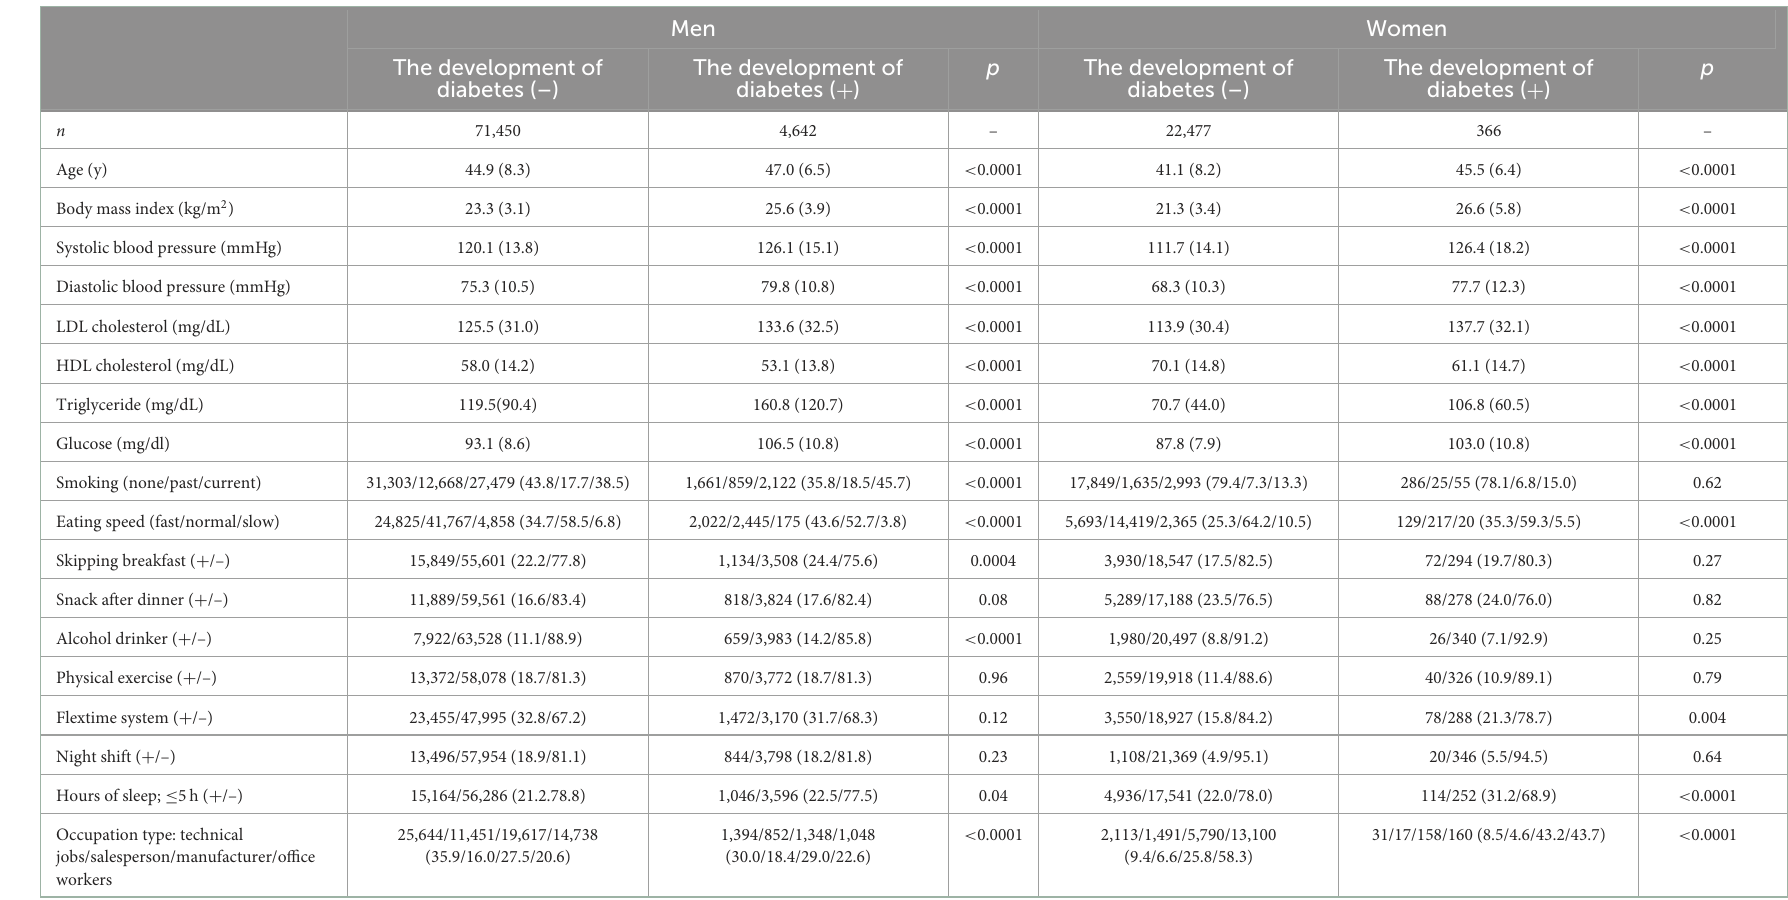
TABLE 3 Characteristics of participants at baseline according to the development of